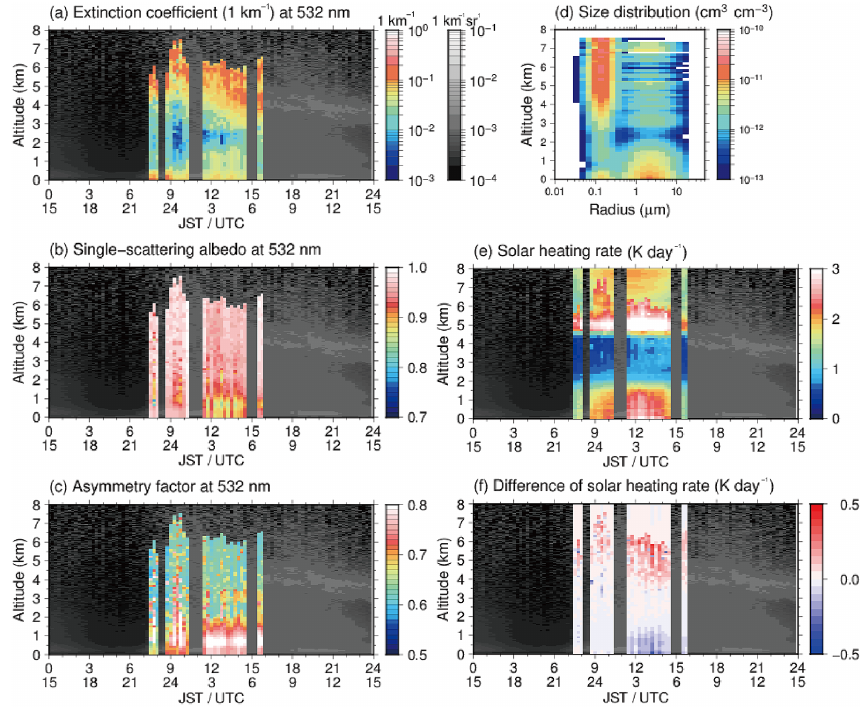
Figure 19. Retrieval results for the transported smoke in 8 May 2013 in Tsukuba, Japan: (a) extinction coefficient at 532nm, (b) single- scattering albedo at 532nm, (c) asymmetry factor at 532nm, (d) size distribution, (e) solar heating rate, and (f) solar heating rate difference from that calculated using the vertical mean of the asymmetry factor. The gray shading is the attenuated backscatter coefficient at 532nm by MIEL.